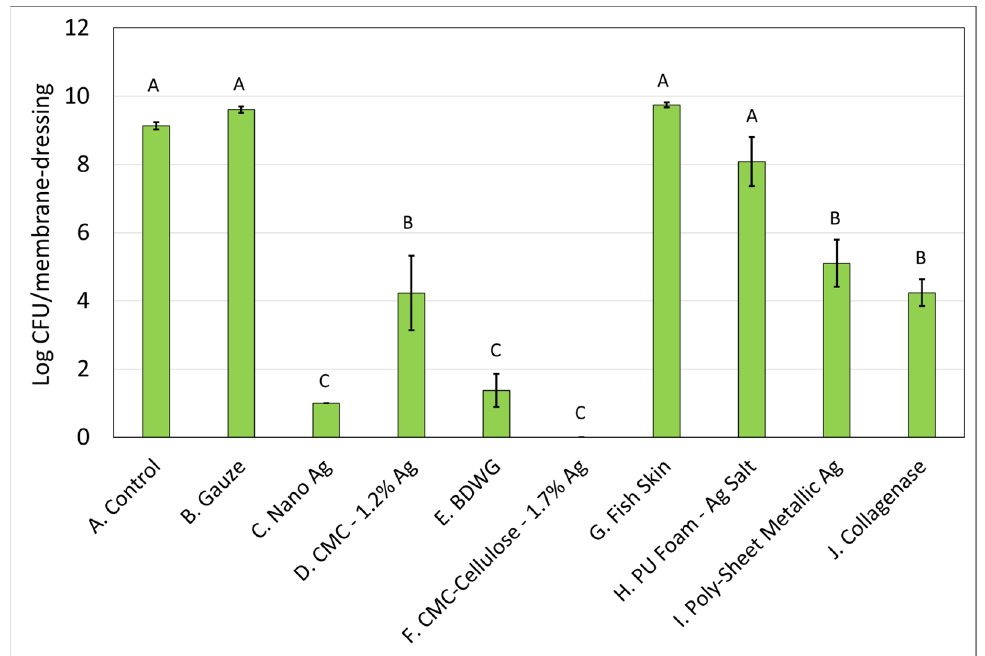
Figure 2. P. aeruginosa Log CFU recovered from membranes inoculated with mixed bacterial species and left untreated (A), treated with saline soaked gauze (B) or treated with wound care products (C through J). If treatments have the same letter listed above the column, they are not statistically different at p = 0.05. The error bars depict the standard error of mean.